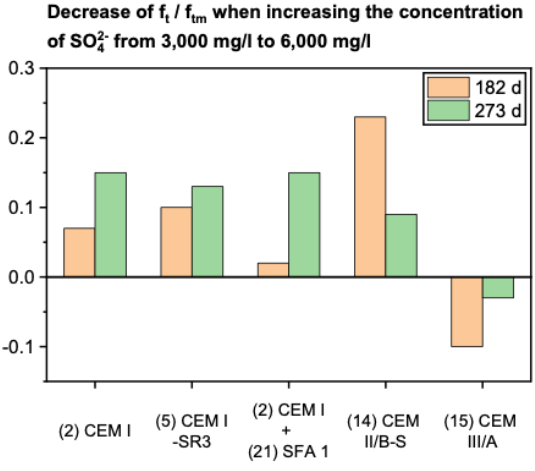
Figure 3. Mean decrease of the rel. tensile strength of the fine concretes with w/c eq = 0.50 with a change of the sulfate concentration of the Na 2 SO 4 solution from 3000 mg/l to 6000